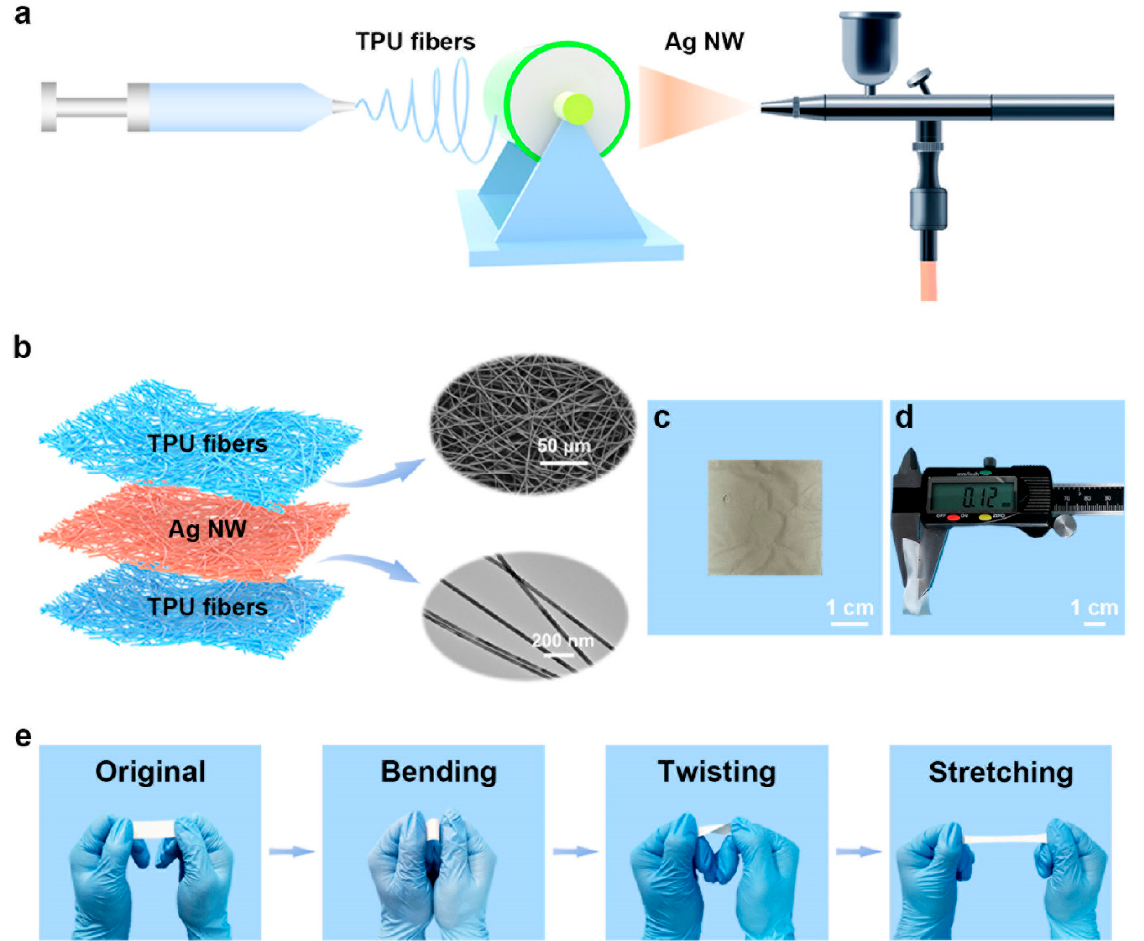
Figure 10. The fabrication and characterization of the TE-skin. ( a ) A schematic diagram of the experimental process for fabricating the TE-skin. ( b ) The sandwich structure of the TE-skin. ( c ) Photograph of the Ag NW electrode layer that is deposited on the TPU fiber substrate. ( d ) Photograph of the TE-skin with a total thickness of 120 µm. ( e ) Photographs of the TE-skin in the original, bent, twisted, and stretched states. Reproduced from Ref. [60] under the Creative Commons Attribution 4.0 International (CC BY 4.0) License.